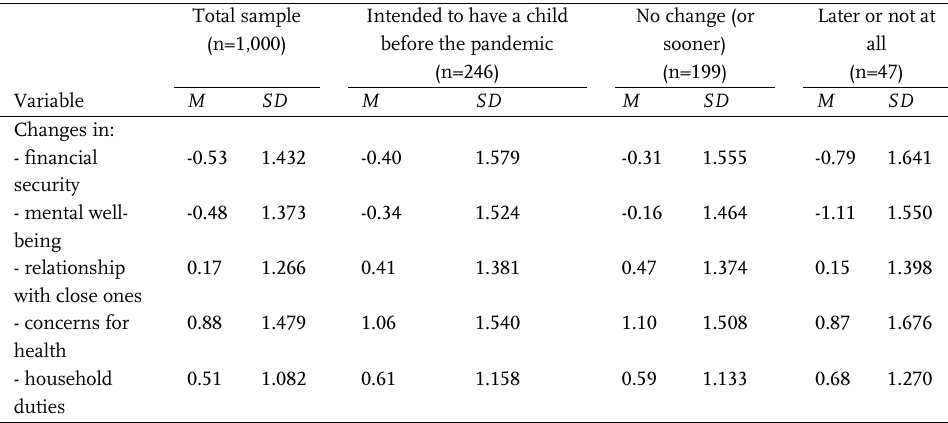
Table 3 : The perceived effect of the pandemic on respondents’ life (n=1,000) Total sample Intended to have a child (n=1,000) before the